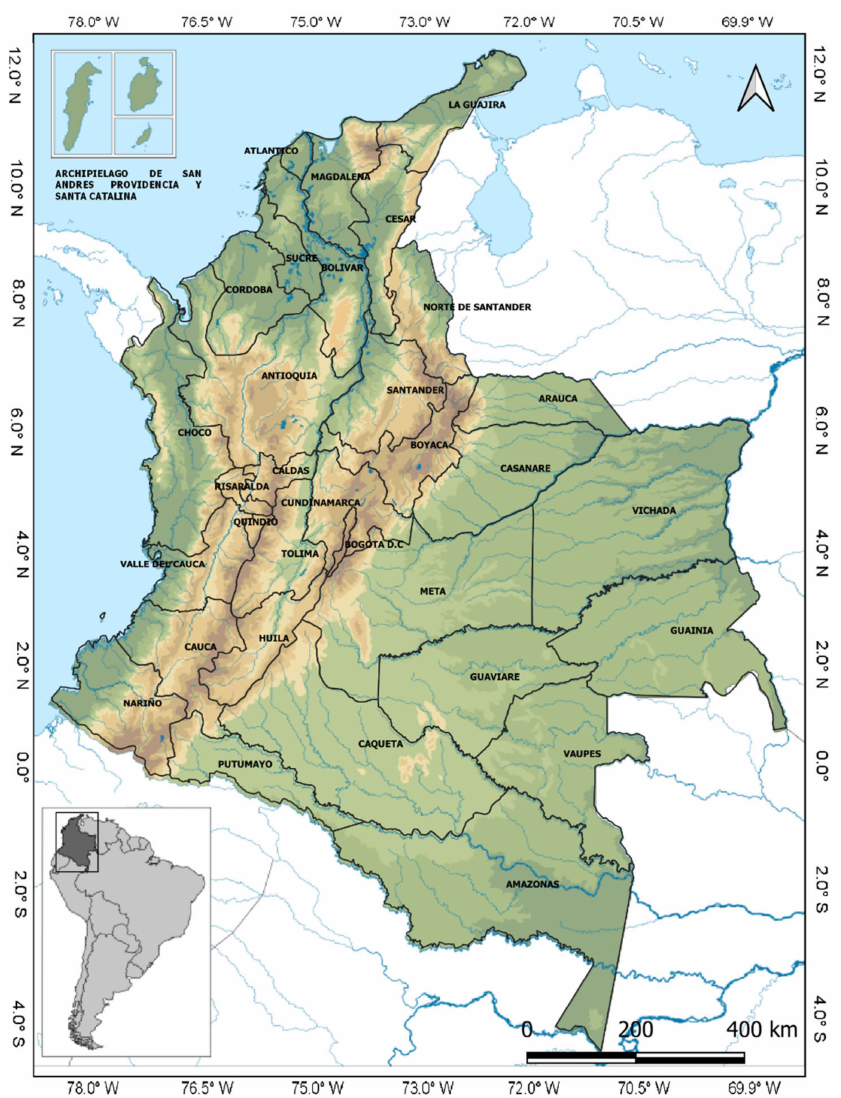
Figure 1. Location of Colombia in South America. Study area covers the entire territory of